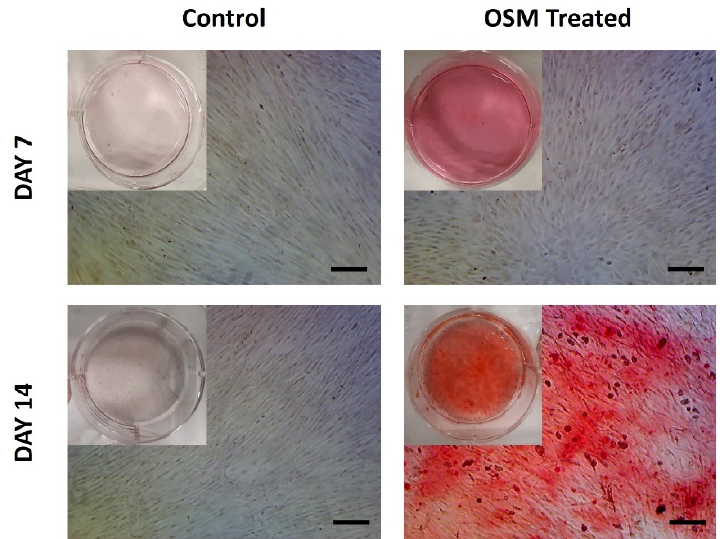
Figure 9. Determination of the osteogenic differentiation potential of the isolated pBMSCs; alizarin red staining of monolayer pBMSCs treated with XPAN and OSM on days 7 and 14 of the culture (Scale: 250 μ m). Macroscopic images of the ARS-stained wells are also presented within the cell